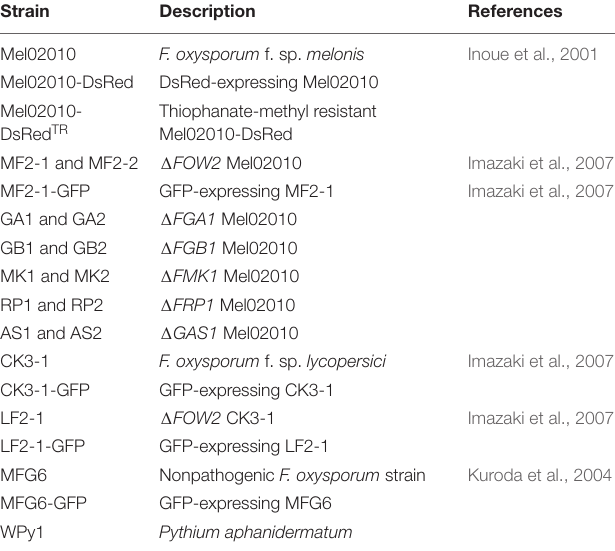
TABLE 1 | Fungal strains used in this